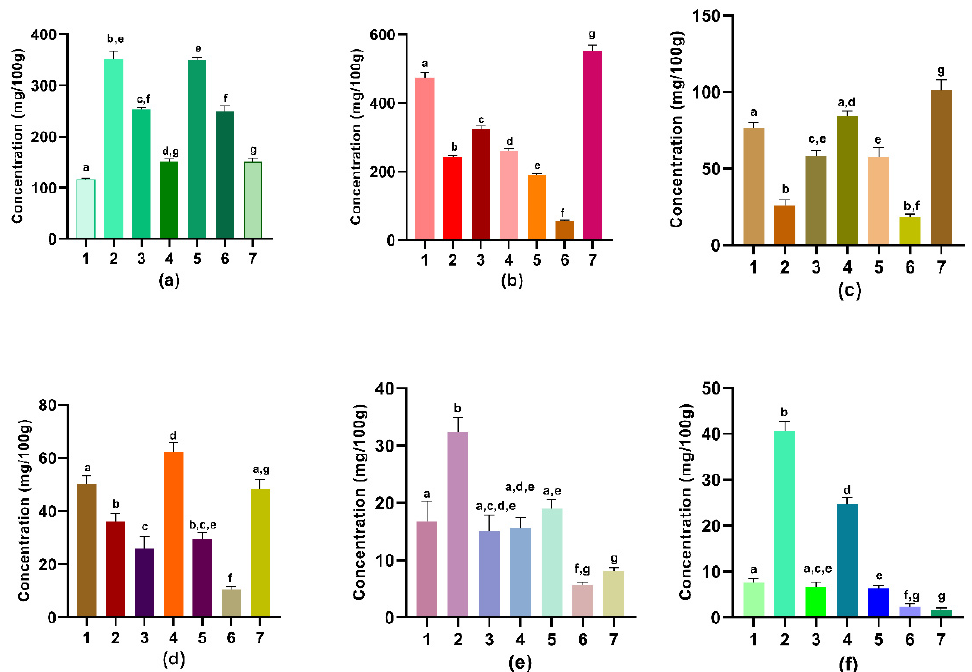
Figure 4. Selected minerals found in the edible plant organs from Solanum nigrescens ( 1 ), Sechium edule ( 2 ), Rumex obtusifolius ( 3 ), Amaranthus hybridus ( 4 ), Piper auritum ( 5 ), Rhamnus pompana ( 6 ), and Yucca aloifolia ( 7 ). The contents of potassium ( a ), calcium ( b ), iron ( c ), sodium ( d ), zinc ( e ), and magnesium ( f ) are shown. Different letters indicate means ( n = 10) with statistically significant differences by ANOVA–Tukey’s test at p < 0.05. Detailed information can be found in Table S3. As for the levels of calcium, the levels of iron were also abundant in Y. aloifolia (101.2 mg 100 g − 1 ) (Figure 4c). Interestingly, the levels of this element were over 70 mg 100 g − 1 in the berries of S. nigrescens and the fresh leaves of A. hybridus (Figure 4c). These levels were higher than those reported for P. maculosa , Plantago major , Spinacia oleracea , Beta vulgaris , and Lactuca sativa [27]. Even, the low levels of iron found in S. edule were higher than those reported for the same vegetables [27]. As a general finding, all plants studied contained low levels of sodium (<50 mg 100 g − 1 ), which could be safe for people with hypertension (Figure 4d). Nevertheless, statically significant differences were observed among sodium levels of A. hybridus , Y. aloifolia , and S. nigrescens (Figure 4d). The observed concentrations were lower than those reported for Spinacia oleracea , Beta vulgaris and Lactuca sativa [27]. Zinc levels in the edible organs of R. obtusifolius S. ngrescens , A. hybridus , P. auritum , R. pompana , and Y. aloifolia were below 20 mg 100 g − 1 , whereas those of S. edule were 32.4 mg 100 g − 1 (Figure 4e). The levels of zinc in these plants were substantially higher than those found in S. oleracea , B. vulgaris , L. sativa , and P. maculosa [12,27]. Coincidently, the concen- tration of magnesium in S. edule was the highest (40.6 mg 100 g − 1 ) among studied quelites (Figure 4f). These results clearly stated that the seven quelites studied may provide sig- nificant amounts of minerals to complete the daily requirements for maintaining optimal metabolic performance. Nevertheless, since the accumulation of minerals depends on abi- otic factors such as soil composition and climate, further studies are required to determine possible influence of seasons and geographical location on the mineral concentration in plant organs [11,12,27].